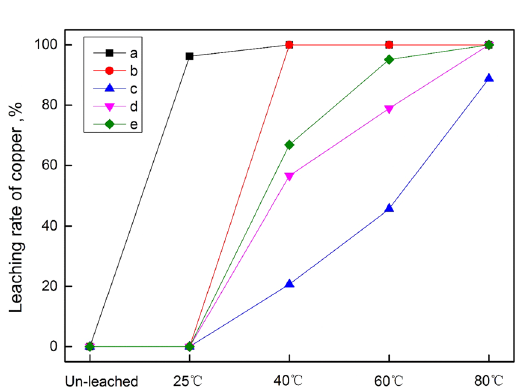
Figure 6. Leaching rate of copper in copper-bearing minerals at different temperatures. ( a ) Malachite, chrysocolla and pseudo-malachite. ( b ) Copper-bearing chlorite. ( c ) Copper-bearing limonite. ( d ) Copper- bearing biotite. ( e ) Copper-bearing